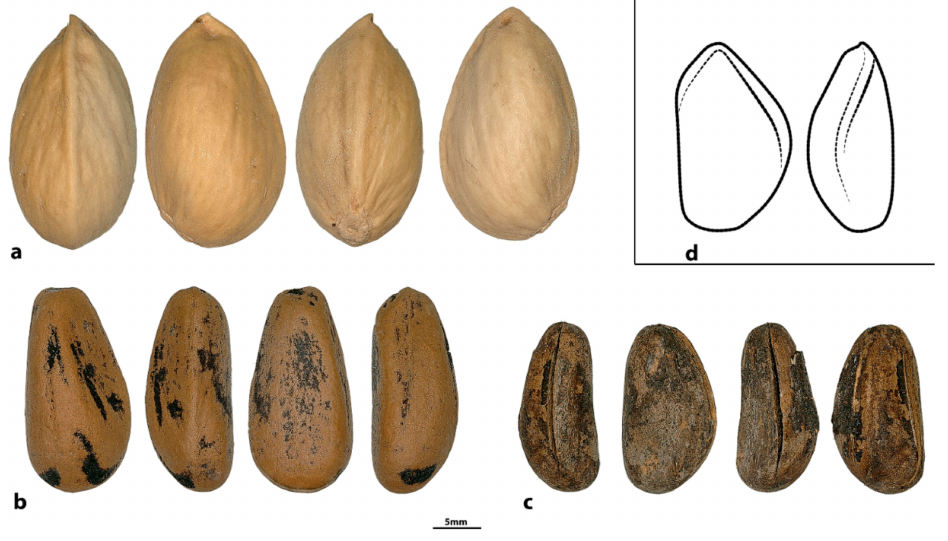
Figure 1. ( a )—modern cultivated pistachio nut; ( b , c )—modern pine nuts; ( d )—figure from Pefkakia- Magoula, Greece (recreated from [95]) formerly identified as true